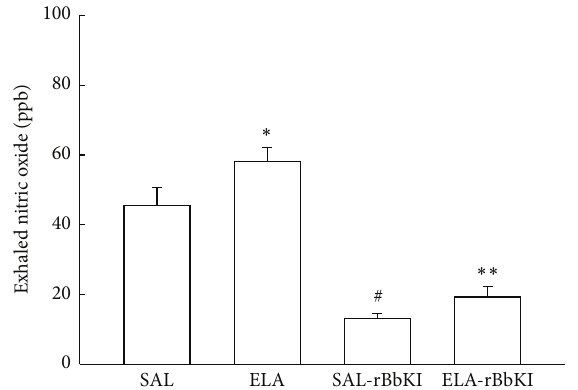
Figure 5: Exhaled nitric oxide ( ∗ 𝑃 < 0.05 compared with SAL and SAL-rBbKI groups; ∗∗ 𝑃 < 0.05 compared with ELA-rBbKI group; # 𝑃 < 0.05 compared with SAL group).